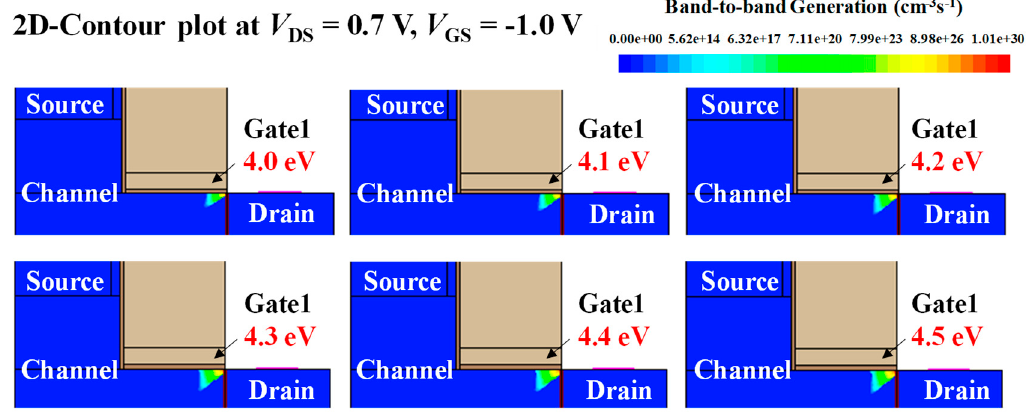
Figure 7. 2-D contour plot of BTBT generation for various ϕ G1 . As ϕ G1 decreases, BTBT rate decreases.